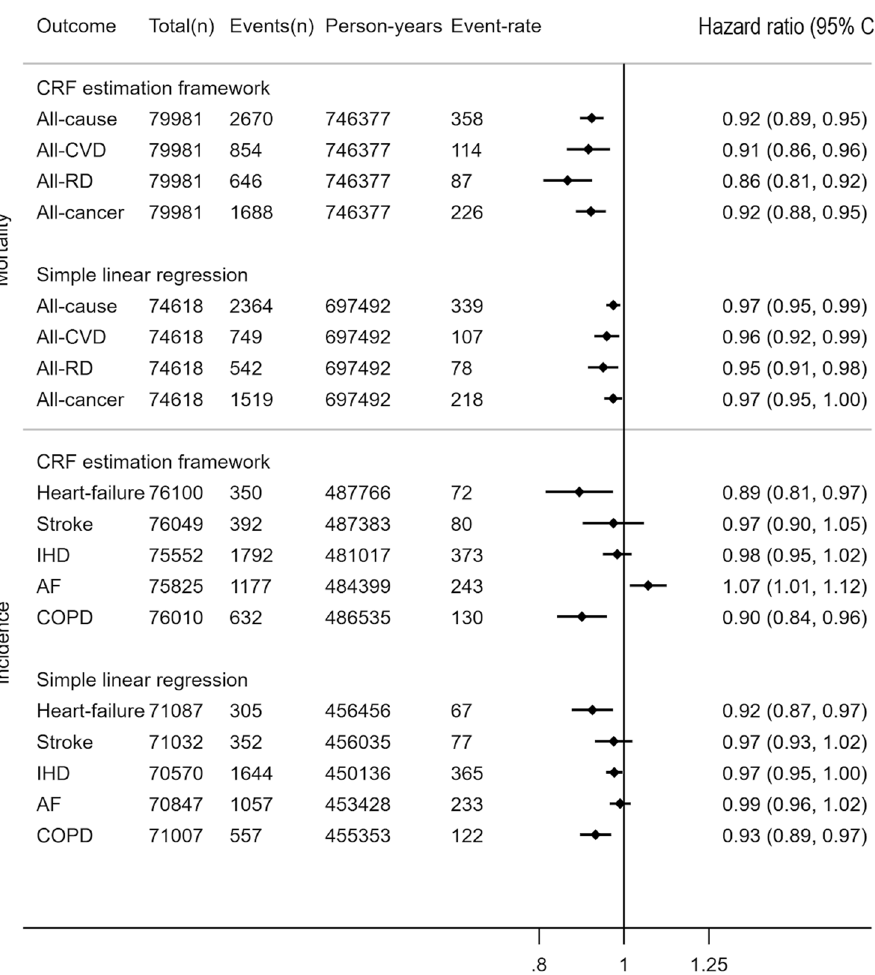
Figure 5. Hazard ratio and 95% confidence interval (CI) for prospective log-linear associations (Cox regression) between fatal and non-fatal outcomes in the UK Biobank with cardiorespiratory fitness in metabolic equivalents (METs, per 3.5 ml O 2 ·kg −1 min −1 ) computed from the multilevel framework and simple linear regression methods. Event-rate per 100,000 person-years. AF: atrial fibrillation; COPD: chronic obstructive pulmonary disease; CVD: cardiovascular disease; IHD: ischaemic heart disease; RD: respiratory disease. COPD incidence mostly reflects severe COPD since only ~ 25% of cases end up in hospital. Mortality and incidence event-rates differ between fitness prediction methods owing to different inclusion criteria at the estimation